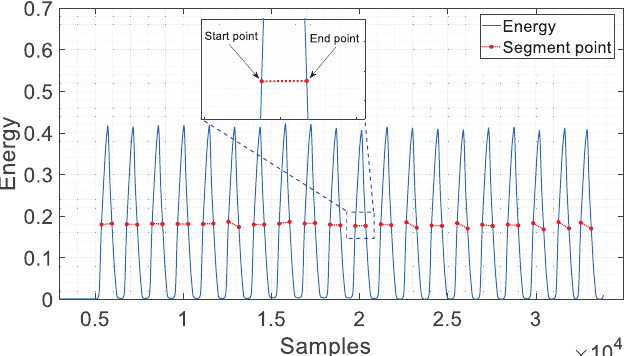
Figure 7. The energy envelope and boundary points of